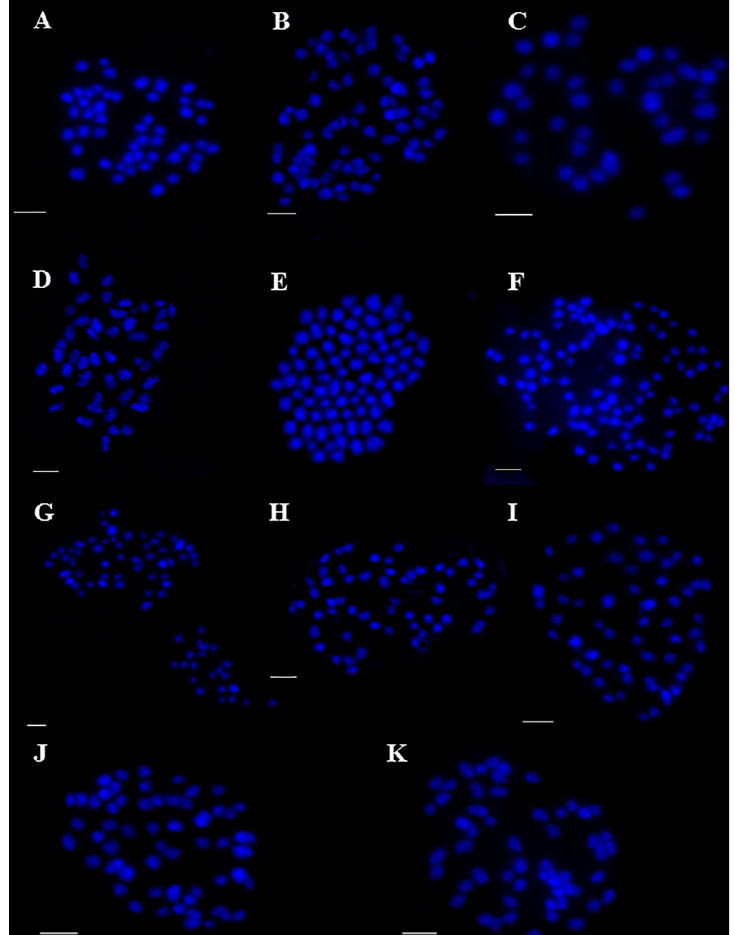
Fig 2. Mitotic metaphase chromosome spreads of the analysed Carex taxa. (A) C . secalina , 2n = 50; (B) C . songorica , 2n = 82; (C) C . supina , 2n = 38; (D) C . tomentosa , 2n = 48; (E) C . bohemica , 2n = 80; (F) C . buxbaumii , 2n = 102; (G) C . diluta , 2n = 74; (H) C . hordeistichos , 2n = 58; (I) C . otomana , 2n = 56; (J) C . pairae , 2n = 58; (K) C . pallidula , 2n = 56. Scale bar = 2.5 μ